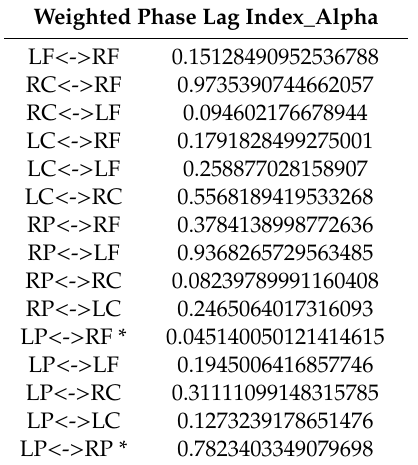
Table A4. p -Values Obtained for the Weighted Phase Lag Index Connectivity Analysis in the Alpha Band. * indicates